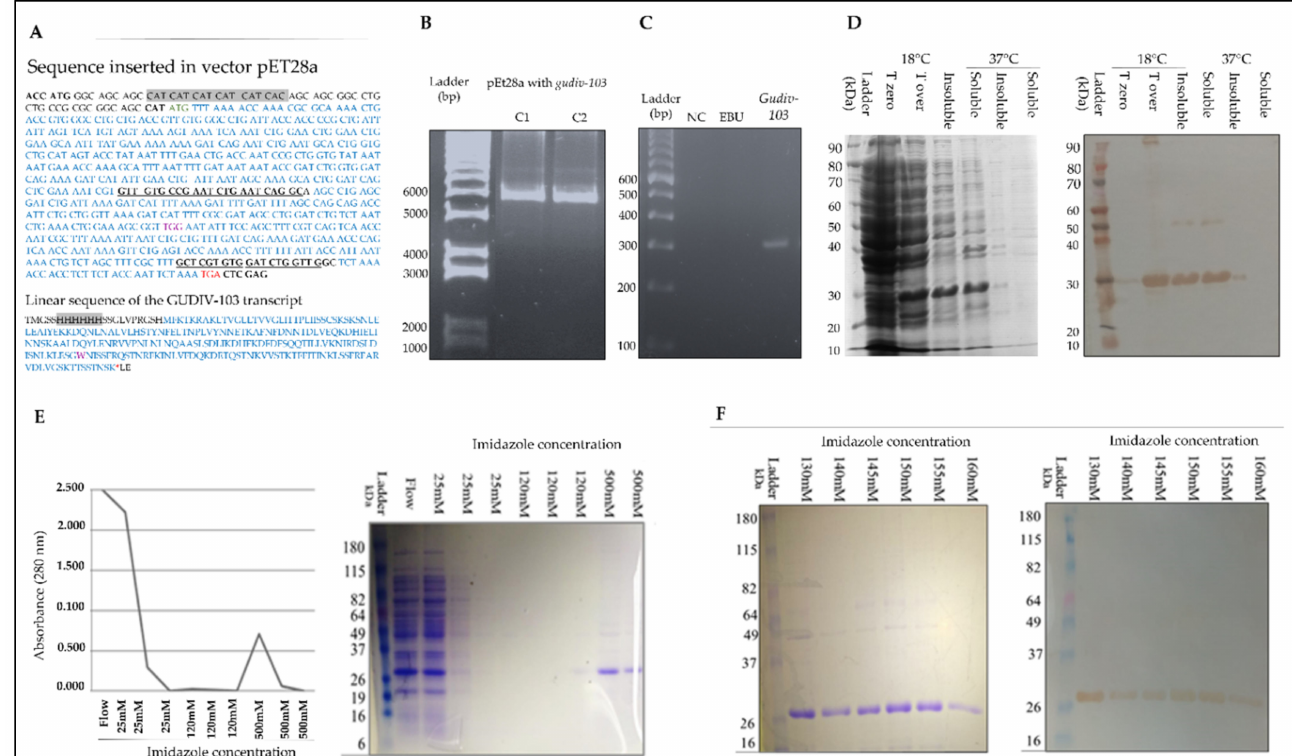
Figure 1. Cloning, heterologous expression, and purification of recombinant GUDIV-103 (rGUDIV-103). ( A ) Top, nucleotide sequence inserted into the pET28a(+) vector; bottom, trans- lation of the inserted sequence. Green, red, grey, and purple nucleotides correspond to the GUDIV translation start codon, stop codon, N-terminal histidine tail, and the TGG codon encoding tryp- tophan, which replaces the TGA codon in Escherichia coli , respectively. The underlined sequences were used to build the forward and reverse primers for assessing gene insertion. ( B ) Agarose gel electrophoresis of plasmids isolated from two different One Shot TOP10 transformants (C1 and C2). ( C ) Agarose gel electrophoresis of PCR-amplified GUDIV-103 fragment using the primers stated in panel A and DNA extracted from E. coli BL21 (DE3) Star transformed with pET-28a(+) gudiv-103 vector. EBU: untransformed E. coli BL21 (DE3) Star; NC: negative control—all elements of the re- action except the target DNA. Ladder: Marker TrackIt 100 bp DNA ladder (Invitrogen, S ã o Paulo, Brazil). ( D ) Assessing different expression temperatures on GUDIV_103 solubility by sodium do- decyl sulphate–polyacrylamide gel electrophoresis (SDS–PAGE) (left) and Western blotting (right). T-zero: total uninduced E. coli BL21 (DE3) Star extract; T over: rGUDIV-103 expression in E. coli BL21 (DE3) Star after overnight isopropyl β - D -1-thiogalactopyranoside (IPTG) induction. Bands at approximately 27 kDa correspond to GUDIV_103 expression. Insoluble: insoluble fraction of the total bacterial extract after induction; soluble: soluble fraction of the bacterial extract after induction. Ladder: Novex Sharp pre-Stained Protein Standard (Thermo Fisher Scientific). ( E ) Left, monitoring HisTrap purification of GUDIV_103 by spectrophotometry (280 nm) using 25 and 120 mM imidazole wash steps, followed by elution with 500 mM imidazole; right, SDS–PAGE. Flow: eluate before imidazole wash steps. ( F ) Purification and optimisation using 130–160 mM imidazole in the wash step, followed by elution with 500 mM imidazole; analysed by SDS–PAGE (left) and Western blotting (right). Ladder: Novex Sharp protein standard